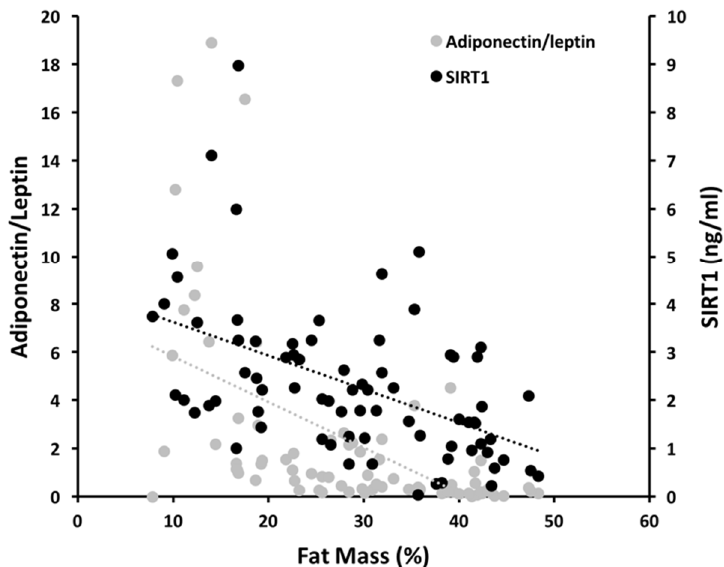
Figure 3. SIRT1 plasma concentration and adiponectin/leptin ratio in relation to the adipose tissue expansion. Grey dots represent the adiponectin/leptin ratio; black dots are the SIRT1 single values. Linear regression between SIRT1 and fat mass % (black broken line); linear regression between adiponectin/leptin ratio and fat mass % (grey broken line).